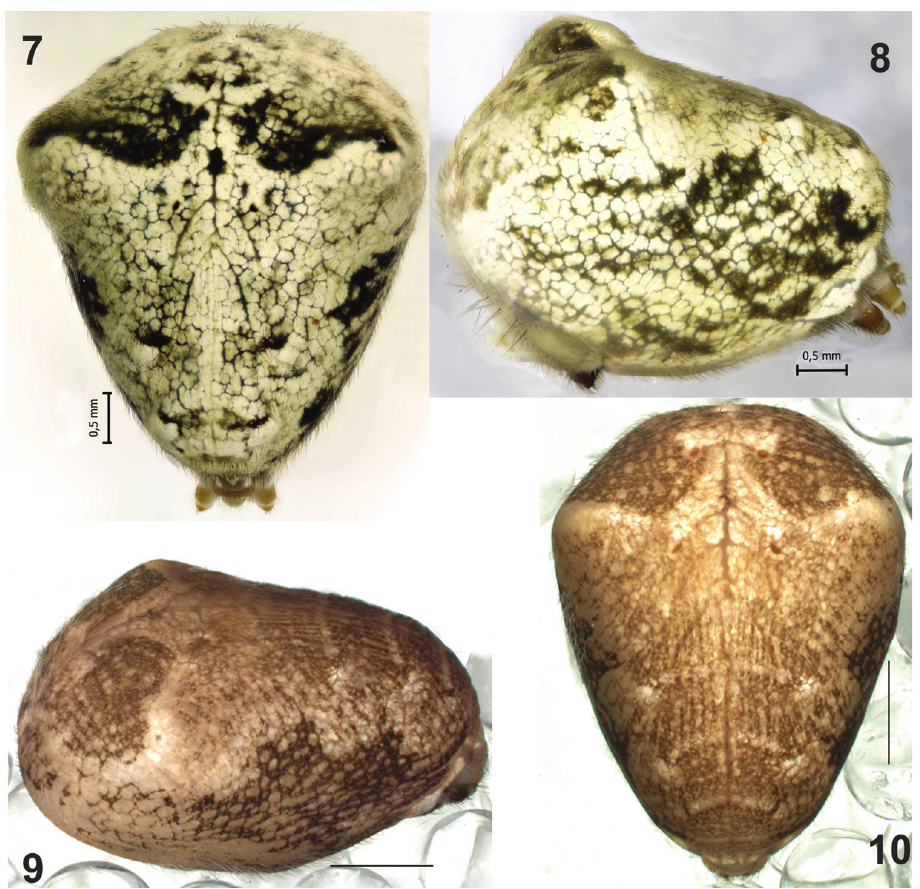
Figures 7–10. Abdomen of Metellina kirgisica ( 7–8 ) from Azerbaijan and M. orientalis ( 9–10 ) from Erzincan Province of Turkey. 7, 10 dorsal 8–9 lateral. Scalebars 0.5 mm ( 7, 8 ); 1 mm ( 9, 10 )